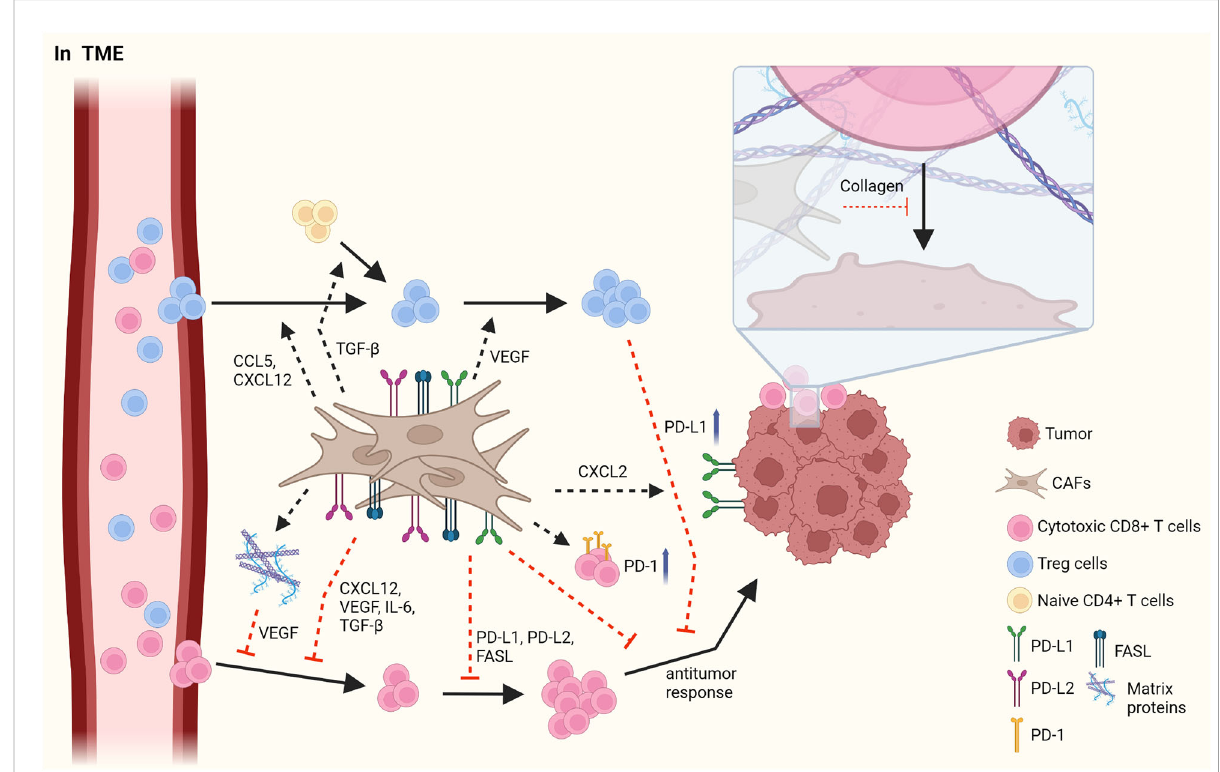
FIGURE 1 The interaction between CAFs and T cells in TME. CAFs have immunosuppressive roles by affecting Treg cells and cytotoxic CD8+ T cells. CAFs elicit the in fi ltration of Treg cells by secretion of CCL5 and CXCL12 and increase the proliferation of them through VEGF. In addition, CAFs facilitate the skewing of naïve CD4+ T cells to Treg cells. However, CAFs obstruct the migration of CD8+ T cells via various cytokines and chemokines such as CXCL12, VEGF, IL-6, and TGF- b . CAFs decrease the frequency and the activation of CD8+ T cells by PD-L1, PD-L2 and FASL. In addition, CAFs suppress an anti-tumor response of CD8+ T cells by upregulating PD-1 expression on the surface of T cells and by increasing PD-L1 expression on tumor through CXCL2. LRRC15+ CAFs induced by TGF- b signaling regulate anti-tumor response of CD8+ T cells. Furthermore, the accumulation of matrix protein, which is produced by CAFs can obstruct the migration of T cells and collagen can block the access of T cells to tumor, limiting the anti-tumor activity of T cells. Figure is generated with biorender